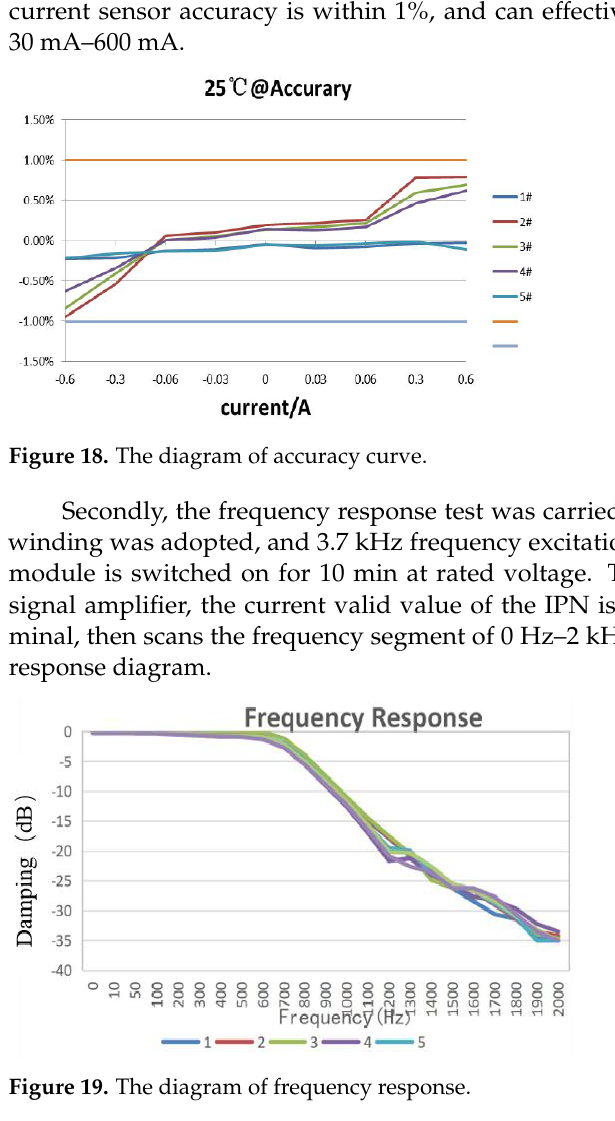
Figure 19. The diagram of frequency response.